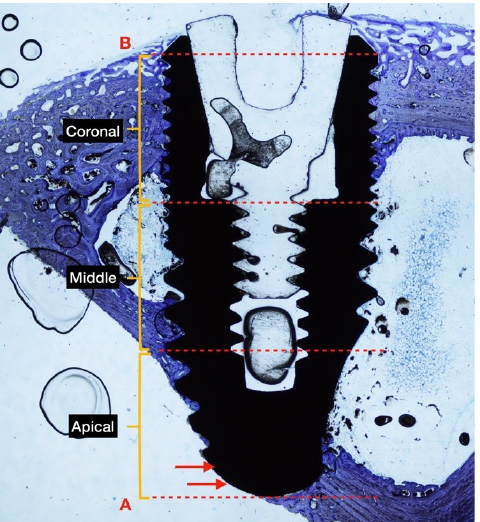
Figure 2. The ground section of rabbit tibia in diaphysis position at 4 weeks of healing. The implant is divided into 3 equal sections (coronal, middle, apical) for BIC measurement. Two points were traced: (B) The most coronal part of the bone to implant contact, and (A) the base of the implant. The implant surface outside of the cortical bone is not considered in the analysis (red arrows). Original magnification × 2 was used, as was toluidine blue